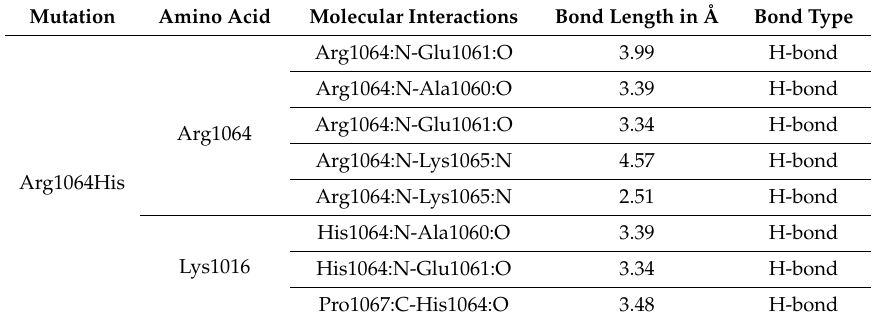
Table 8. Details of molecular interactions of Arg1064 and His1064 of the modeled TIE1 protein with adjacent